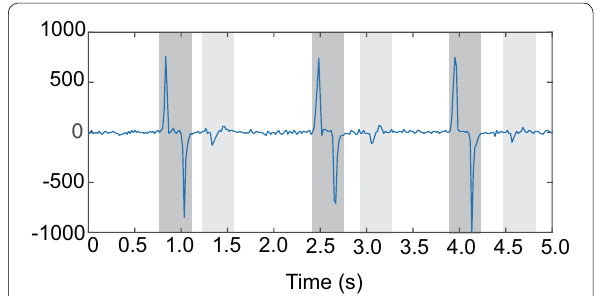
Fig. 7 Differentiated signal from a reflective optical sensor due to voluntary eyelid closure, which is installed toward the tail of the eye. The blue line shows the differentiated signals due to voluntary eye closure (dark gray) and light eyelid closure (light